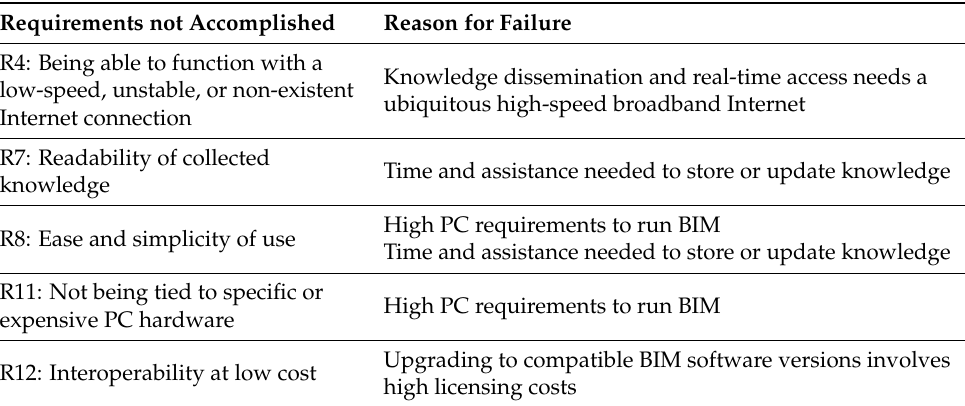
Table 2. Construction SMEs’ requirements for a KM platform that are not accomplished by BIM-based